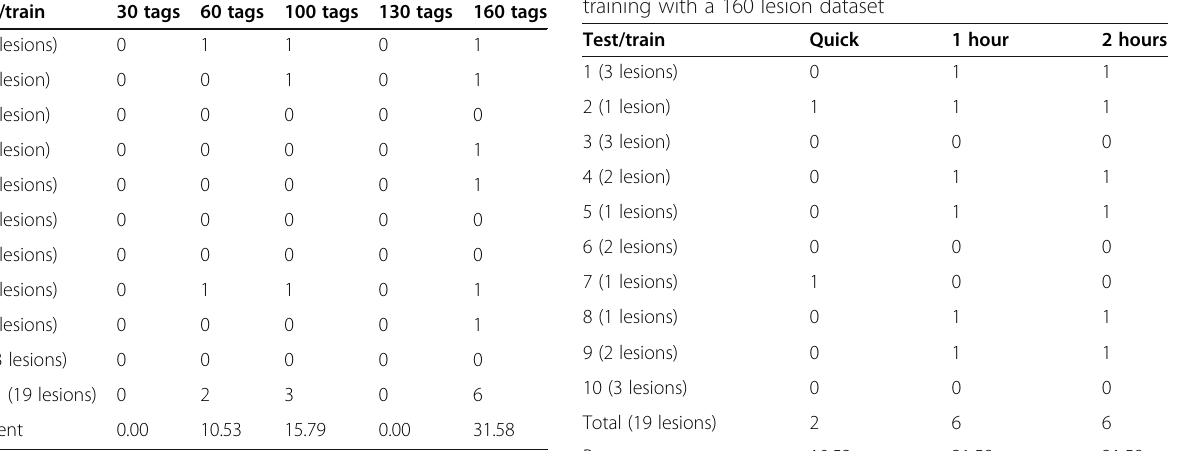
Table 4 The clinical performance of 3 different durations of training with a 160 lesion